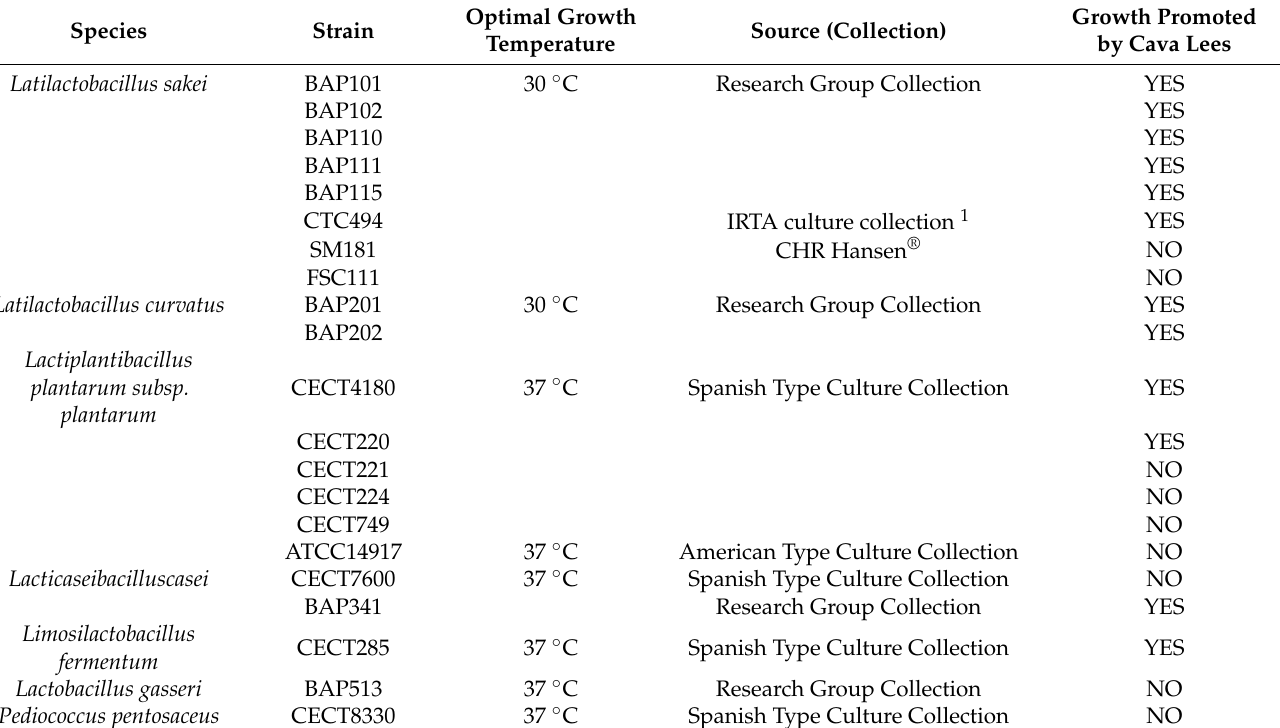
Figure 1. Overall experimental procedure for the in vitro assessment of the effect of cava lees on the growth of different LAB strains. Table 1. Lactic acid bacteria (LAB) strains used in this study.